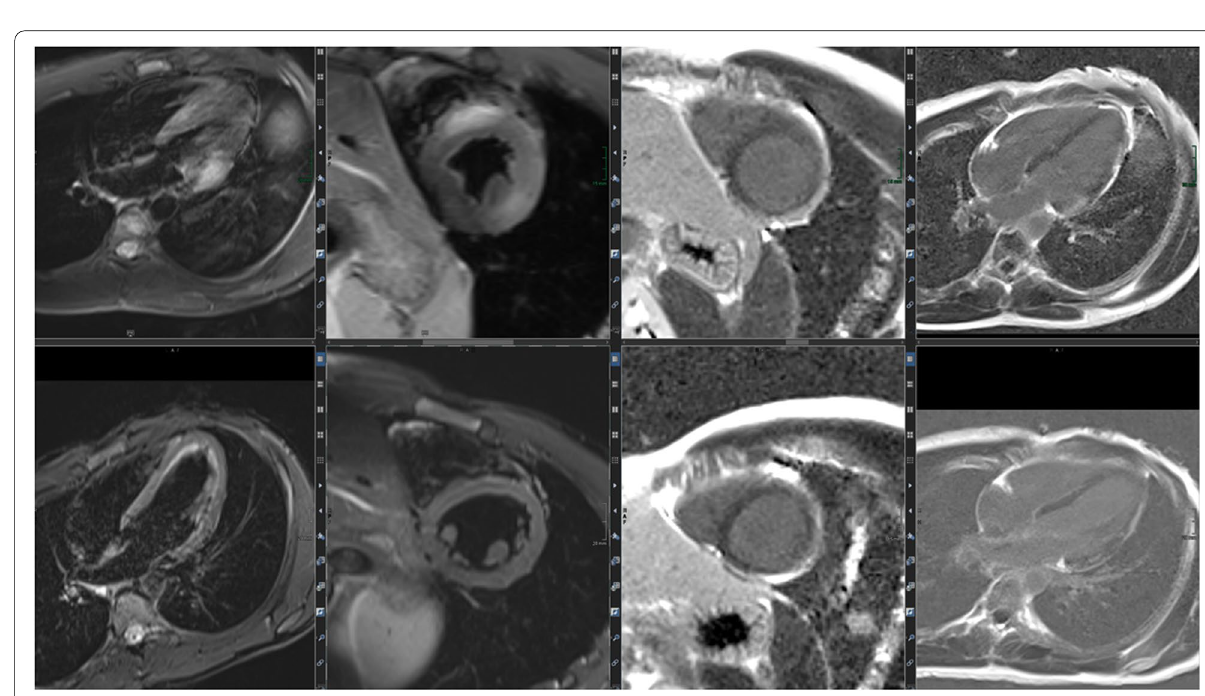
Fig. 16 (T2 and LGE imaging during follow-up): upper row—baseline; lower row—follow-up 10 weeks later. Complete normalization of increased T2 signal in septal and lateral myocardium accompanied by a slight decrease of LGE with the typical subepicardial predominance. Loss of edema signal in conjunct with decreased LGE signal suggests an end of the active inflammatory phase with ongoing repair in altered